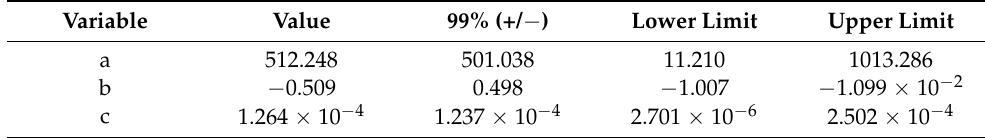
Table 3. Mathematical model coefficients values for a 99% confidence interval of the